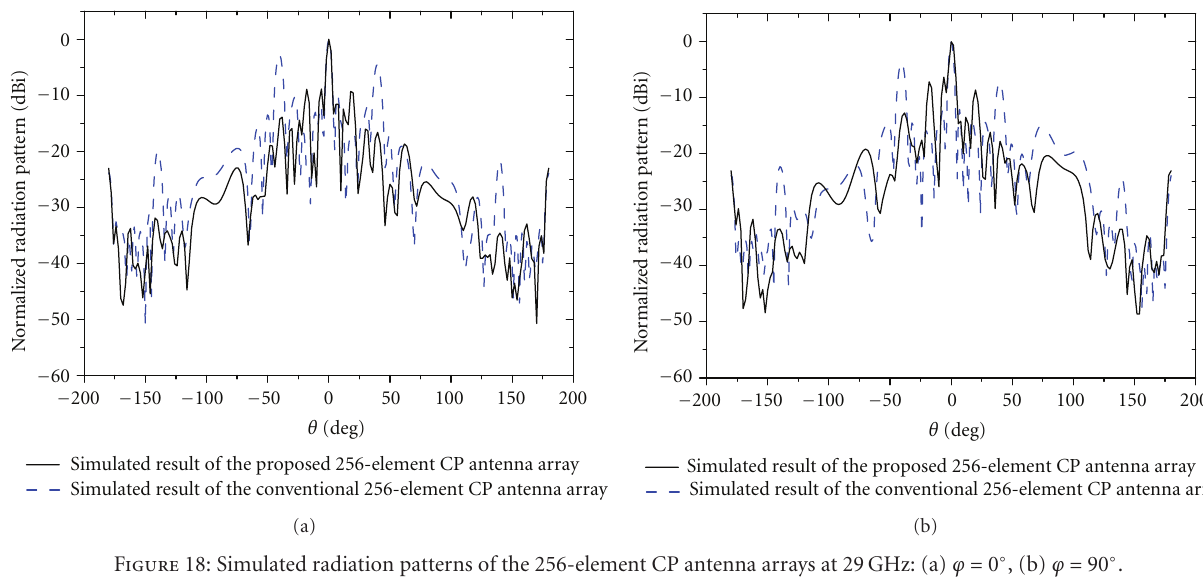
Figure 18: Simulated radiation patterns of the 256-element CP antenna arrays at 29 GHz: (a) ϕ = 0 ◦ , (b) ϕ = 90 ◦